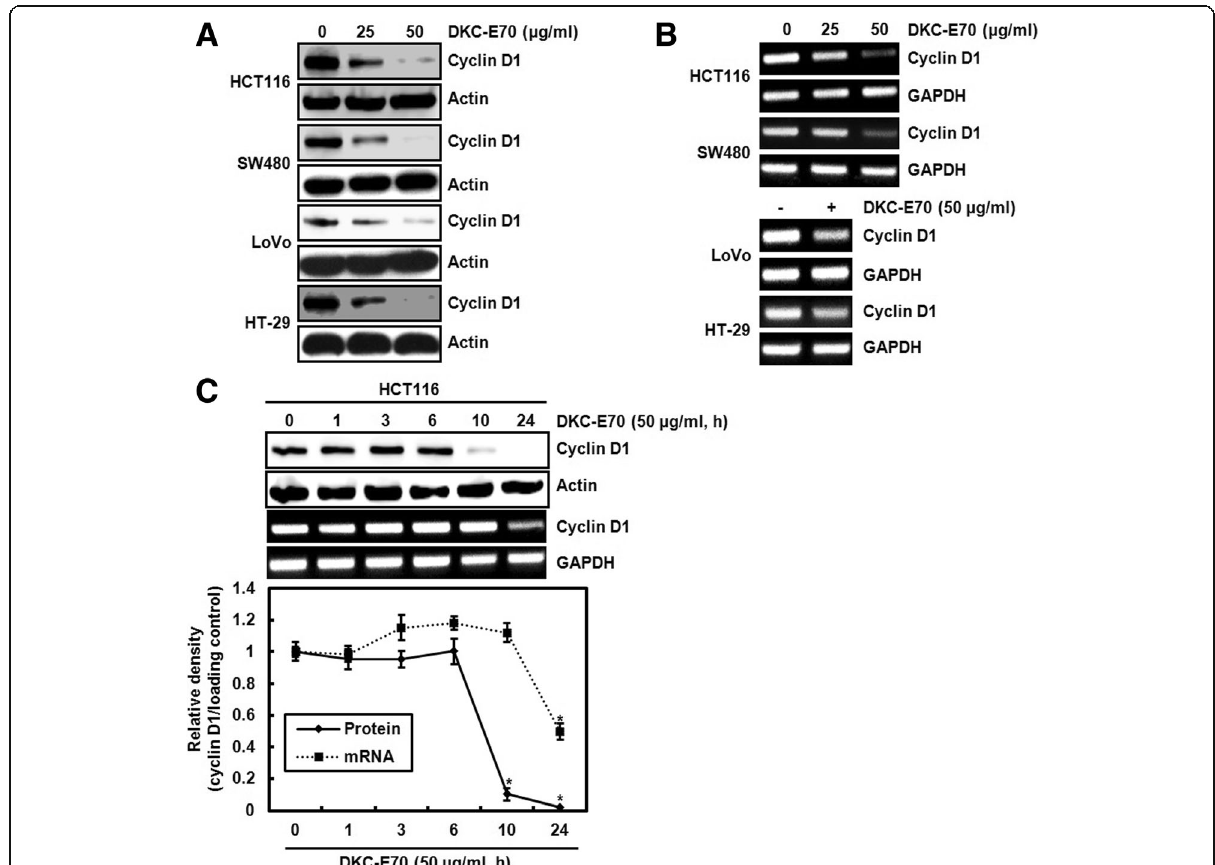
Fig. 2 The effect of DKC-E70 on the expression of cyclin D1 at the protein and mRNA level in human colorectal cancer cells. The cells were plated overnight and then treated with DKC-E70 at the indicated concentrations for 24 h. For Western blot analysis ( a ), cell lysates were subjected to SDS-PAGE and the Western blot was performed using antibody against cyclin D1. Actin was used as internal control for Western blot analysis. For RT-PCR analysis of the gene expression of cyclin D1 ( b ), total RNA was prepared. GAPDH was used as internal control for RP-PCR. ( c ) HCT116 cells were treated with DKC-E70 (50 μ g/ml) for the indicated times. The protein and mRNA level of cyclin D1 was analyzed using Western blot and RT-PCR, respectively. *P < 0.05 compared to cell without DKC-E70